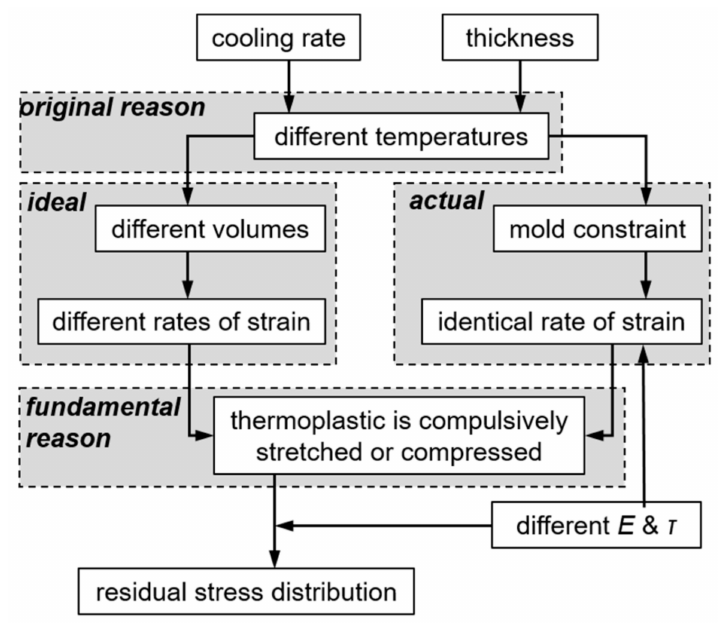
Figure 16. Forming mechanism of residual